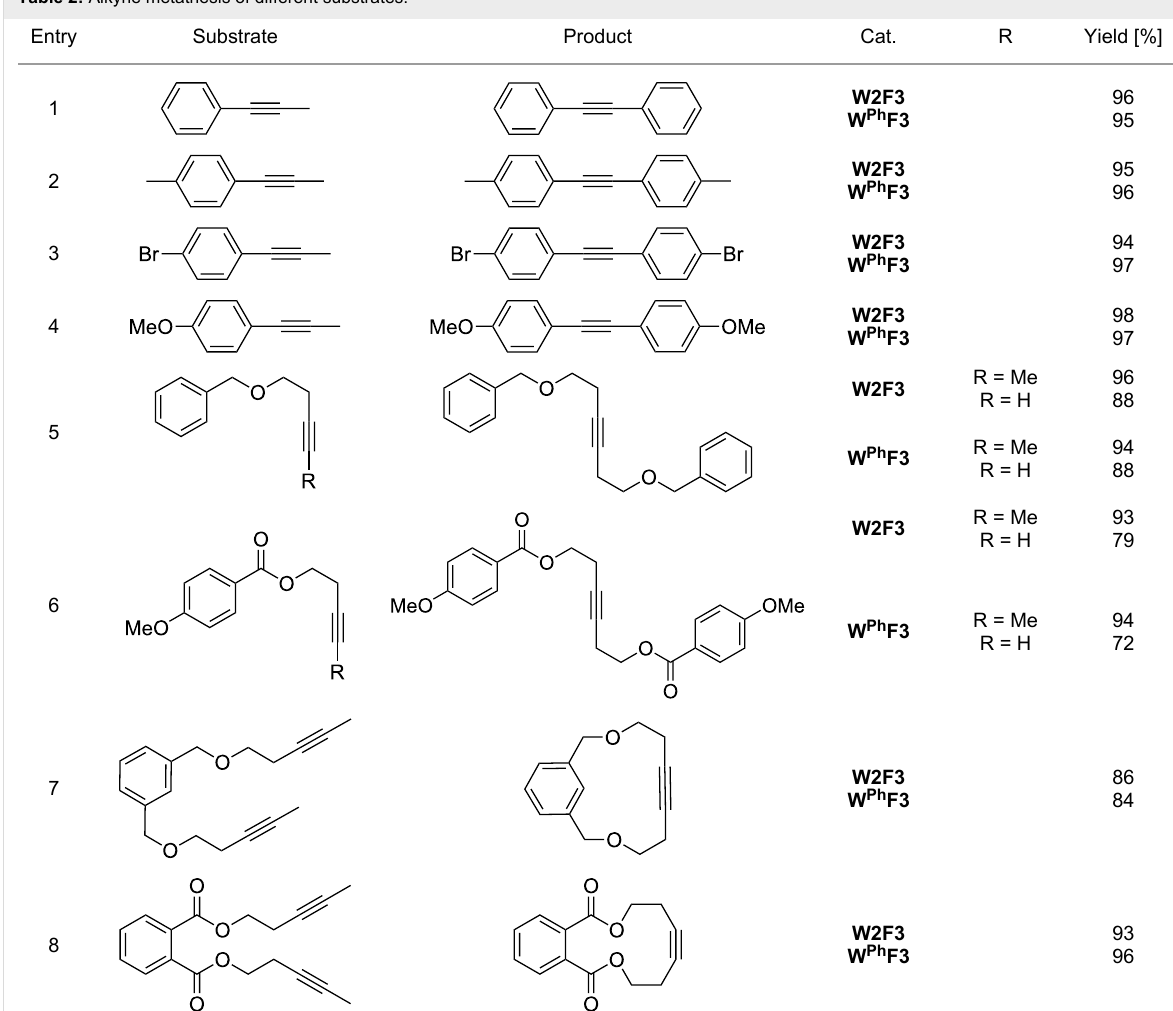
Table 2: Alkyne metathesis of different substrates. a